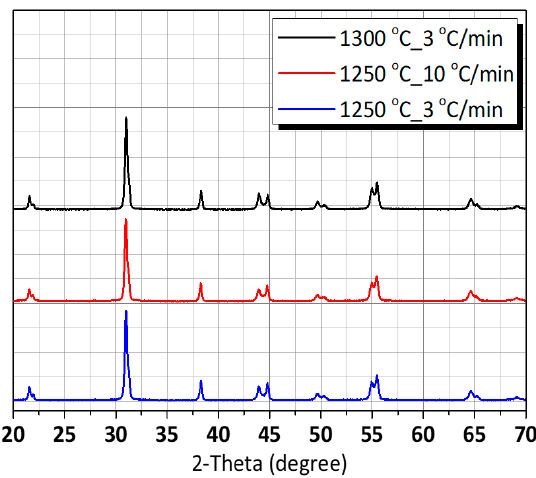
Figure 3. X-ray diffraction ( XRD) patterns of the PZT ceramics in accordance with sintering